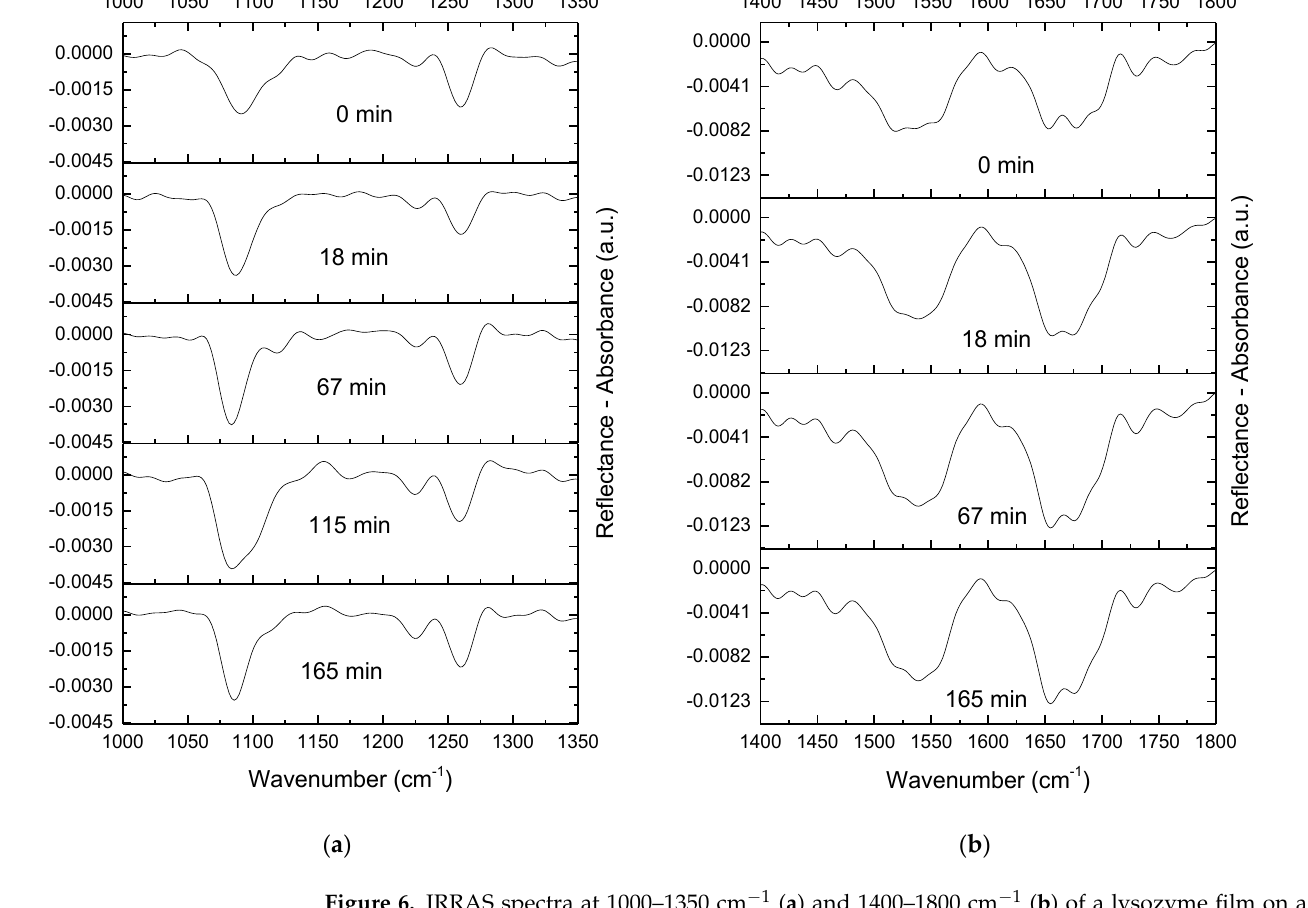
Figure 6. IRRAS spectra at 1000 – 1350 cm − 1 ( a ) and 1400 – 1800 cm −1 ( b ) of a lysozyme film on a DNA-containing subphase at different times after the two-fold surface compression. The total DNA concentration is 50 µM.